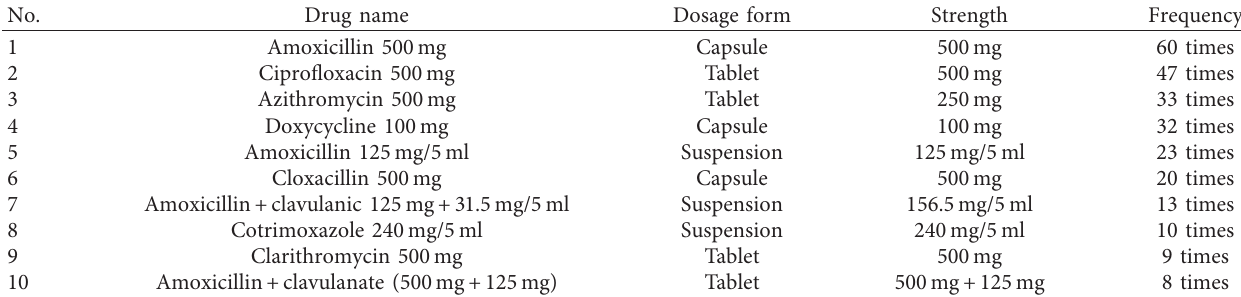
Table 1: List of drugs prescribed frequently in AZH, northwest Ethiopia, from October 11 to November 30, 2019. No.